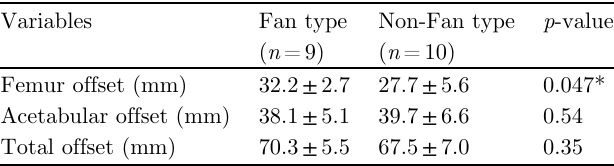
Table 3. Result of preoperative offsets of Fan type and Non- Fan type in patients with lateral femoral cutaneous nerve